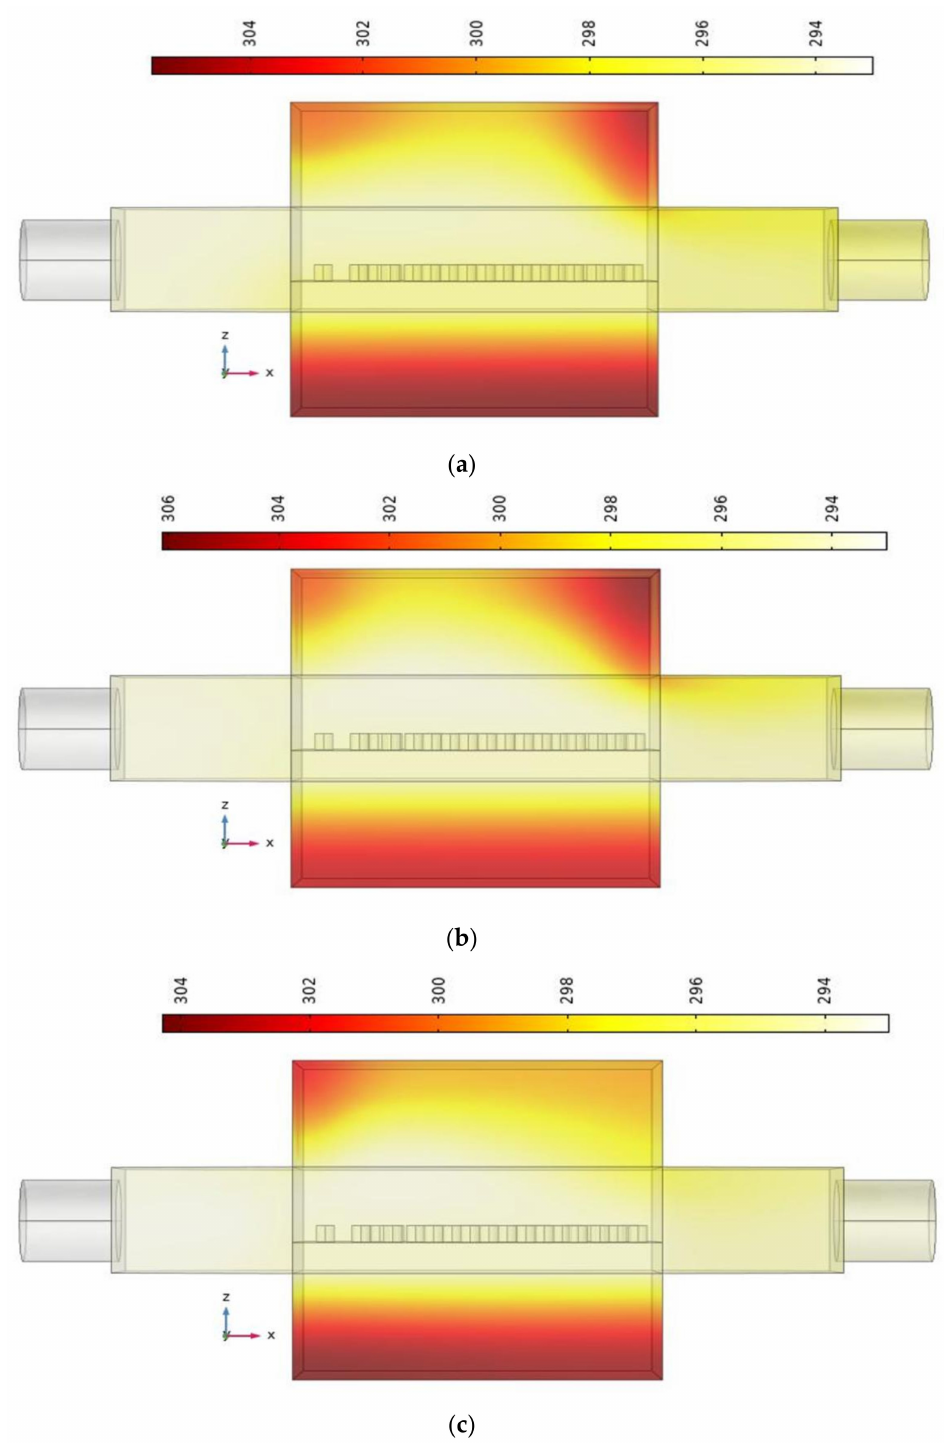
Figure 11. Iso surface temperature distribution at the end of the thermal storage discharging process in the presence of pin-fins ( a ) Re = 50, ( b ) Re = 100, ( c ) Re =